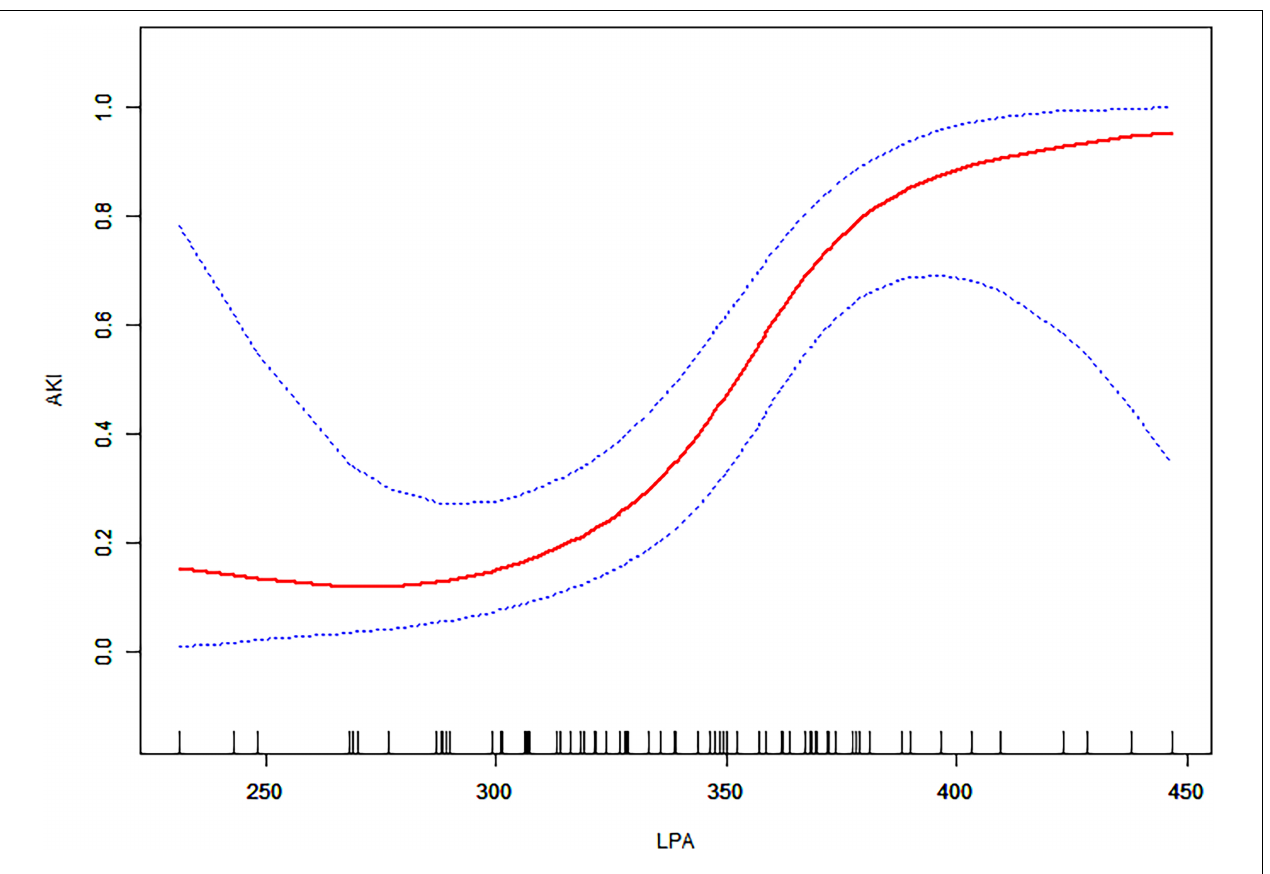
FIGURE 2 | The relationship between admission LPA and AKI. A non-linear association between admission LPA levels and AKI was found in a generalized additive model (GAM). The solid red line represents the smooth curve fit between variables. Blue bands represent the 95% confidence interval from the fit. All adjusted for age, gender, hypertension, diabetes, Marfan syndrome, COPD, medication history of aspirin, Stanford type, WBC, and management.